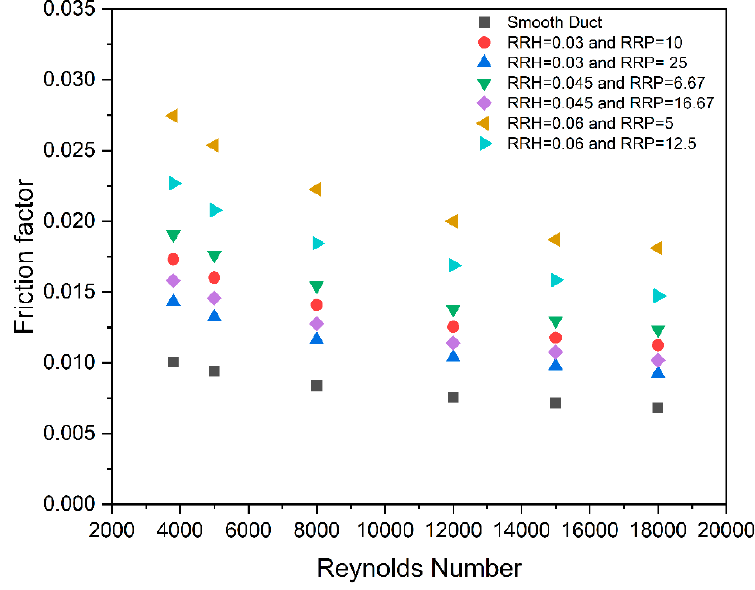
Figure 9. f r versus Re .